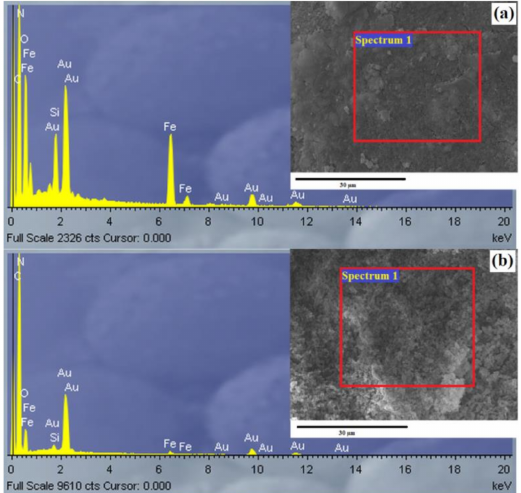
Figure 2. SEM-EDX spectrum of particle surface ( a ) and cross section ( b ) of m-Si-poly(GME)-deta (scale bar: 30 µ